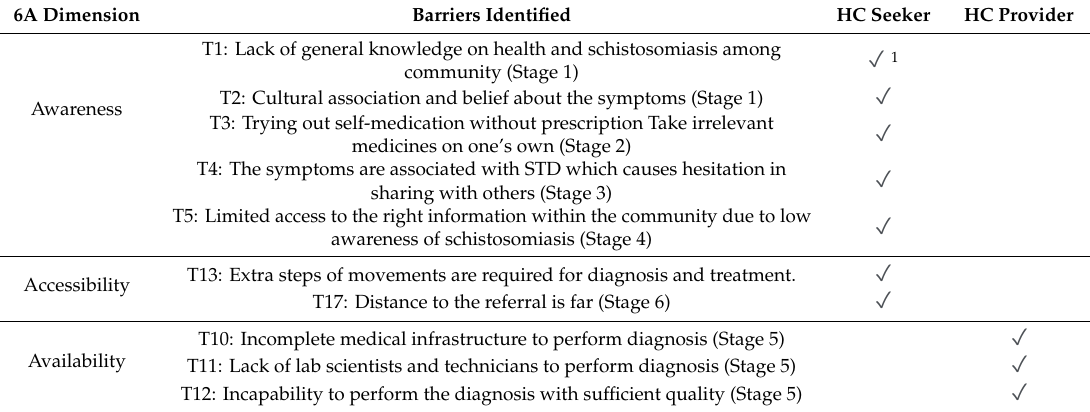
Table A1. Barriers categorized in 6A dimensions and the